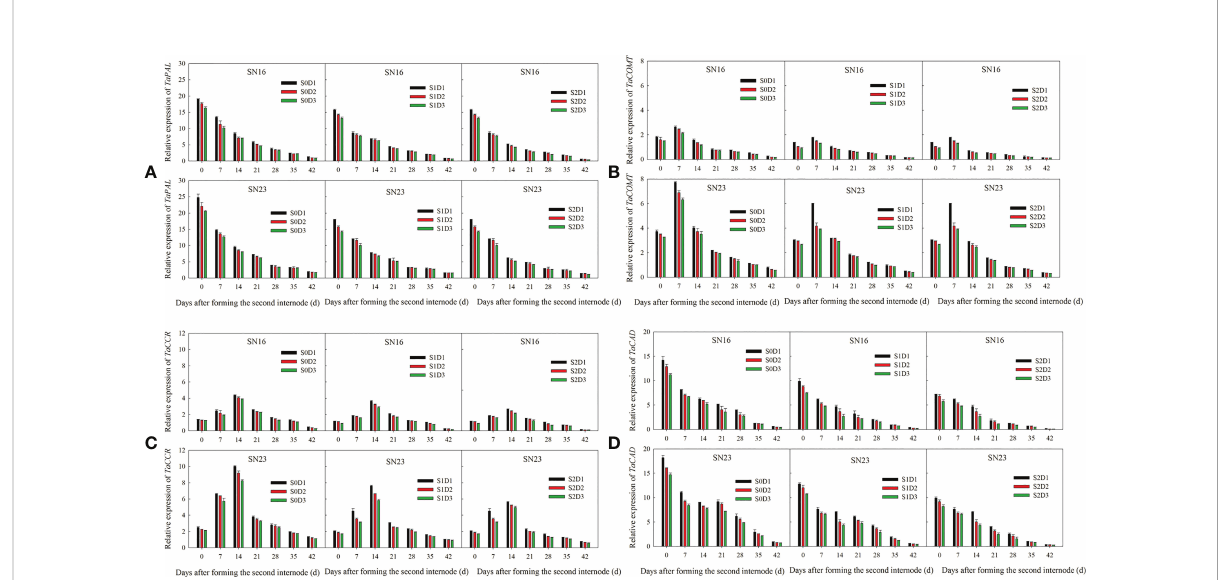
FIGURE 6 Effects of shading on the expression of lignin biosynthetic genes in wheat stems under different planting densities in 2018-2019. Error bars represent the standard deviation of the mean (n = 3). (A) Phenylalanine ammonialyases gene ( PAL ). (B) Caffeic acid O-methyl transferase gene ( COMT ). (C) Cinnamoyl CoA reductase gene ( CCR ). (D) Cinnamyl alcohol dehydrogenase gene ( CAD